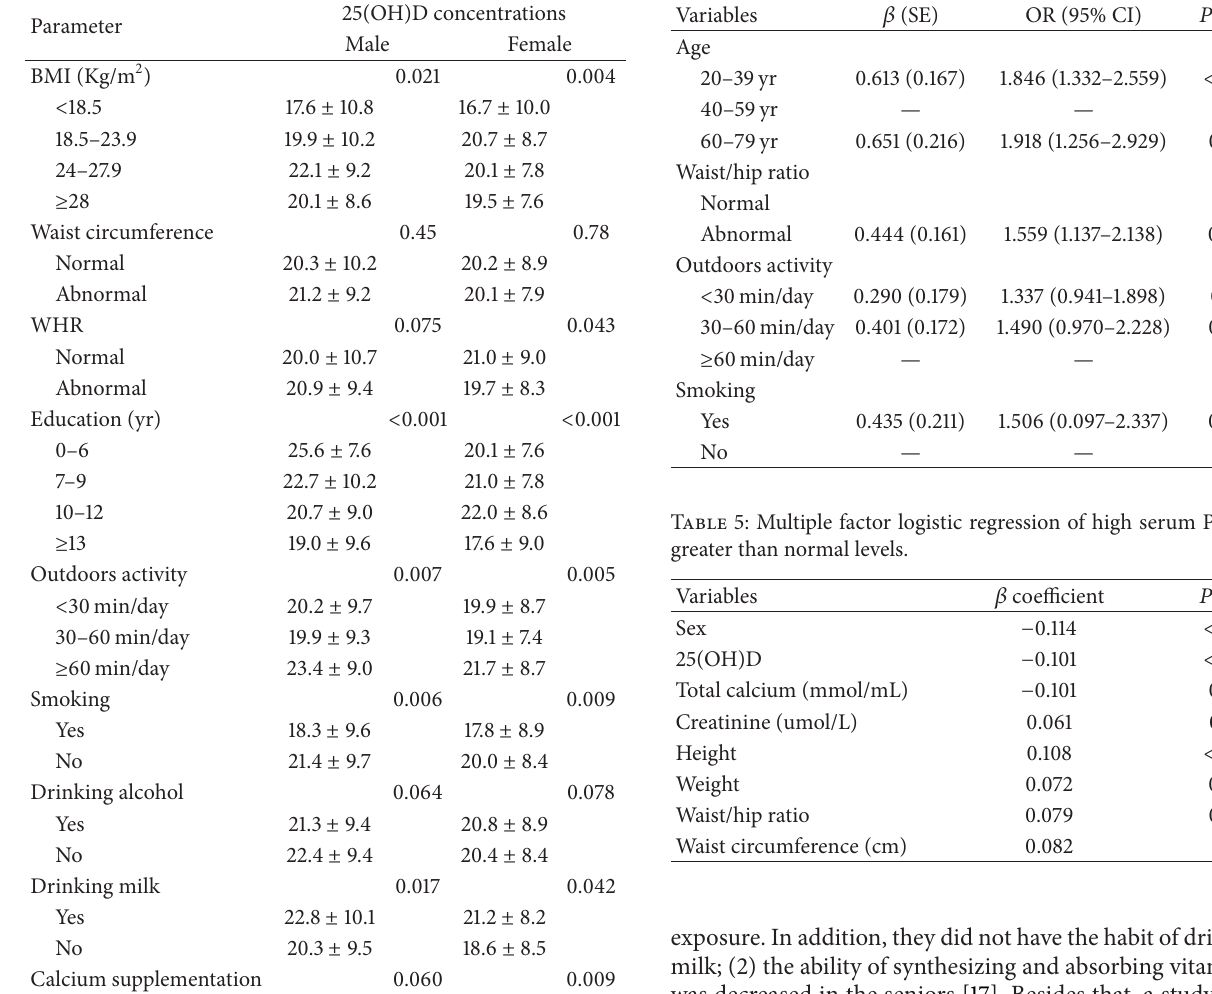
Table 3: 25(OH)D concentrations by participant characteristics ( 𝑛 = 1510 ).